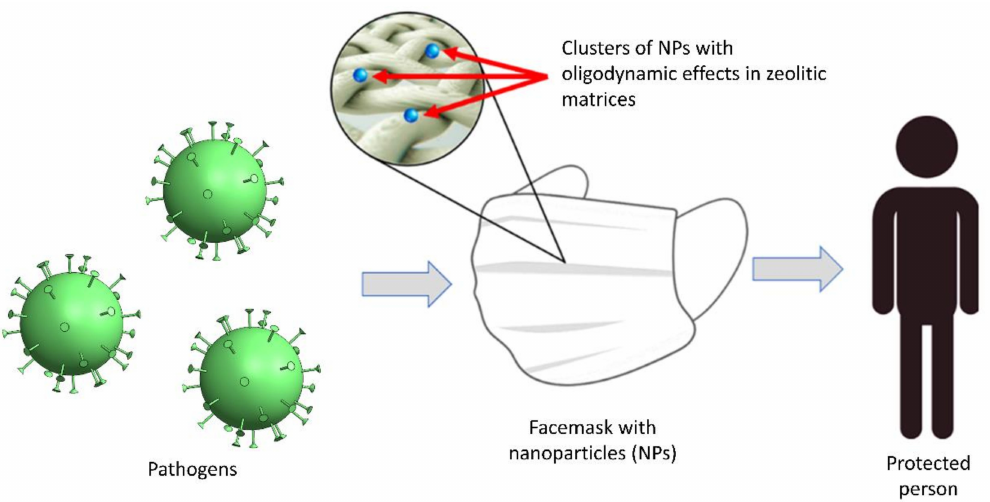
Figure 1. Basic elements in the application of zeolites for fabric